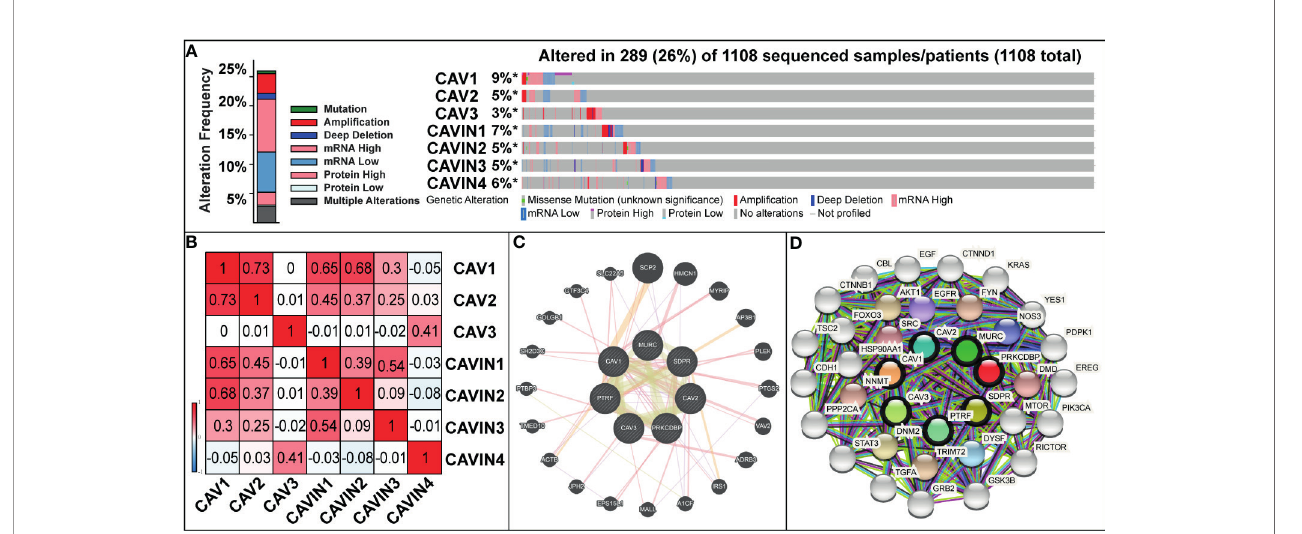
FIGURE 4 | (A) Gene mutation analysis of CAVs and CAVINs in patients with breast cancer. (B) Pearson ’ s correction between CAVs and CAVINs. (C) GeneMANIA analysis of relevant interactive genes of CAVs and CAVINs. (D) Molecular network for CAVs and CAVINs and 37 most frequently altered neighbor